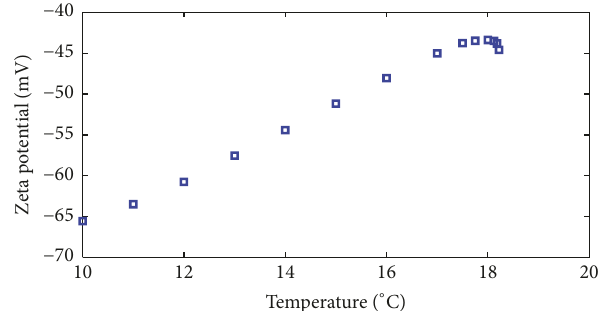
Figure 11: Viscosity of the mixture as a function of temperature at the critical composition (32.1%). The experimental data is obtained from [21, 39].